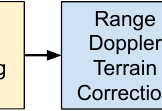
Figure 4. Sentinel-1 processing chain used in the Sentinel Application Platform (SNAP). The yellow box, terrain flattening, was added to the workflow proposed in Filipponi [37] to take into account the local incidence